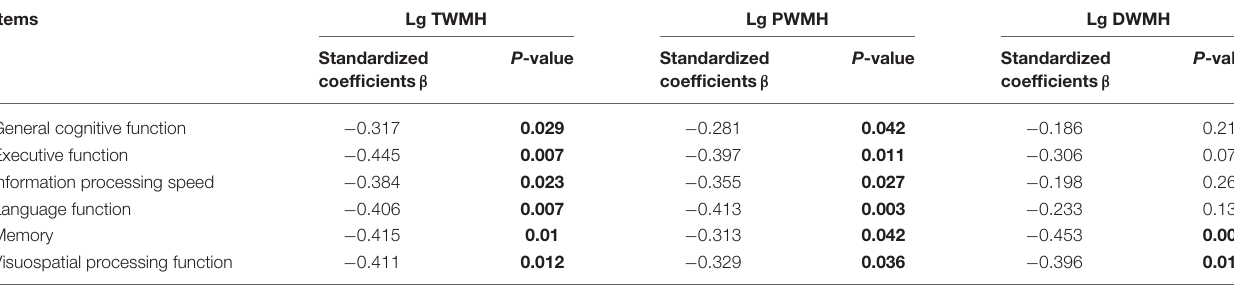
TABLE 2 | Multiple linear regression analyses of WMH volumes and cognitive function in